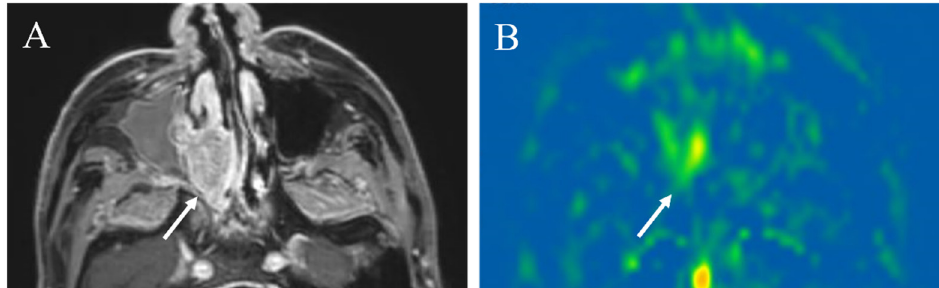
Figure 12. A 87-year-old male with squamous cell carcinoma in the right nasal cavity: ( A ) Contrast- enhanced T1-weighted image shows an enhanced mass (arrow); ( B ) pCASL image shows high blood flow within the lesion (arrow) (TBF mean of 70.17 mL/100 g/min) (arrow).